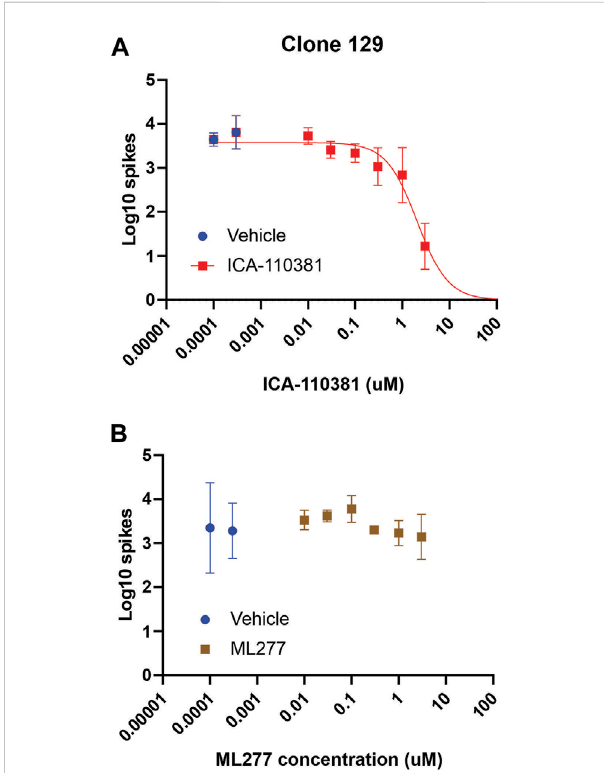
FIGURE 3 ICA-110381 a Kv7.2/Kv7.3 speci fi c activator, attenuates fi ring of iPSC-SNs, while ML277, a Kv7.1 speci fi c activator, does not Spontaneous spiking activity of human iPSC-derived sensory neurons (clone 129) plated into the wells of a 48-well MEA plate. (A) The panel shows the Log10 counts at 37 ° C that after group balancing, the dose-response relationship of the inhibition by ICA-110381 is well determined with an IC 50 of 2.0 µM. ICA-110381 is clearly effective at reducing spontaneous activity of the human iPSC-derived sensory neurons. Spontaneousspiking activityofhuman iPSC-derived sensory neurons (clone 129) plated into the wells of a 48-well MEA plate. (B) The panel shows the Log10 counts at 37 ° C for balanced groups indicate that the inhibitory effect of ML277 at the chosen concentrations is minimal. The attempt to fi t an inhibitory dose- response curve failed and thus is not